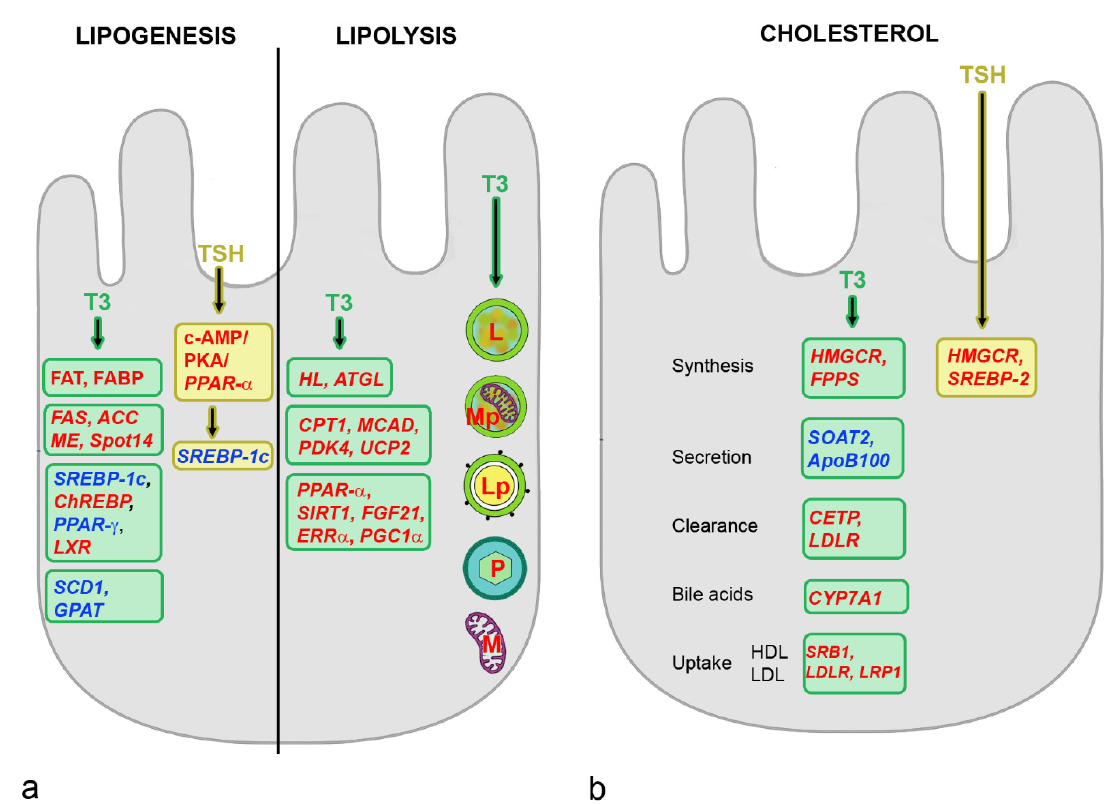
Figure 3. Influence of TH on lipid and cholesterol metabolism. ( a ): T3 stimulates lipogenesis by in- crease of fatty acid translocase (FAT), fatty acid binding protein (FABP), upregulation of fatty acid synthase ( FAS ), acetyl-CoA carboxylase (ACC ), malic enzyme ( ME ), Spot 14 homolog ( Spot14 ), de- crease of sterol regulatory element-binding protein 1c ( SREBP-1c ) and peroxisome proliferator acti- vated receptor (PPAR)- γ combined with increase of cholesteryl ester transfer protein ( ChREBP ) and liver X receptor ( LXR ) and decrease of stearoyl-CoA desaturase ( SCD1 ) and glycerol-3-phosphate acyltransferase ( GPAT ). TSH acts on lipogenesis through upregulation of c-AMP, protein kinase A (PKA) and PPAR- α , which cause activation of SREBP-1c . T3 stimulates lipolysis by upregulation of hepatic lipase ( HL ) and adipose triglyceride lipase ( ATGL ). β -Oxidation is activated by increased expression of CPT1 and the mitochondrial enzymes, medium-chain acyl-CoA dehydrogenase ( MCAD ), pyruvate dehydrogenase kinase isoform 4 ( PDK4 ) and mitochondrial uncoupling protein 2 ( UCP2 ). The CPT1 expression can also be stimulated via PPAR- α , sirtuin 1 (SIRT1), fibroblast growth factor 21 (FGF21), estrogen-related receptor α (ERR α ) and PPAR γ -coactivator 1 α (PGC-1 α ), to increase uptake of fatty acids (FAs) in the mitochondria. Further, synthesis of mitochondria, mi- tophagy, lipophagy, degradation of lipids in lysosomes and enzyme activity of peroxisomes are induced by T3. Abbreviations: L, lysosome; Lp, lipophagy; M, mitochondrion; Mp, mitophagy; P, peroxisome. ( b ): Cholesterol synthesis is affected by T3 at the level of synthesis by induction of β - hydroxy- β -methylglutaryl-CoA reductase ( HMGCR ) and farnesyl pyrophosphate synthase ( FPPS ), secretion by downregulation of sterol O-acyltransferase 2 ( SOAT2 ) and apolipoprotein 100 ( ApoB100 ), clearance by upregulation of cholesteryl ester transfer protein ( CETP ) and low-density lipoprotein receptor ( LDLR ), excretion by upregulation of CYP7A1 and uptake of HDL cholesterol by scavenger receptor class B ( SRB1 ) and of LDL cholesterol by LDLR and low-density lipoprotein receptor-related protein ( LRP1 ). Cholesterol levels are increased by TSH through upregulation of HMGCR and SREBP-2 . Increased levels are indicated by red and decreases by blue color. Regulated genes are written in italics.